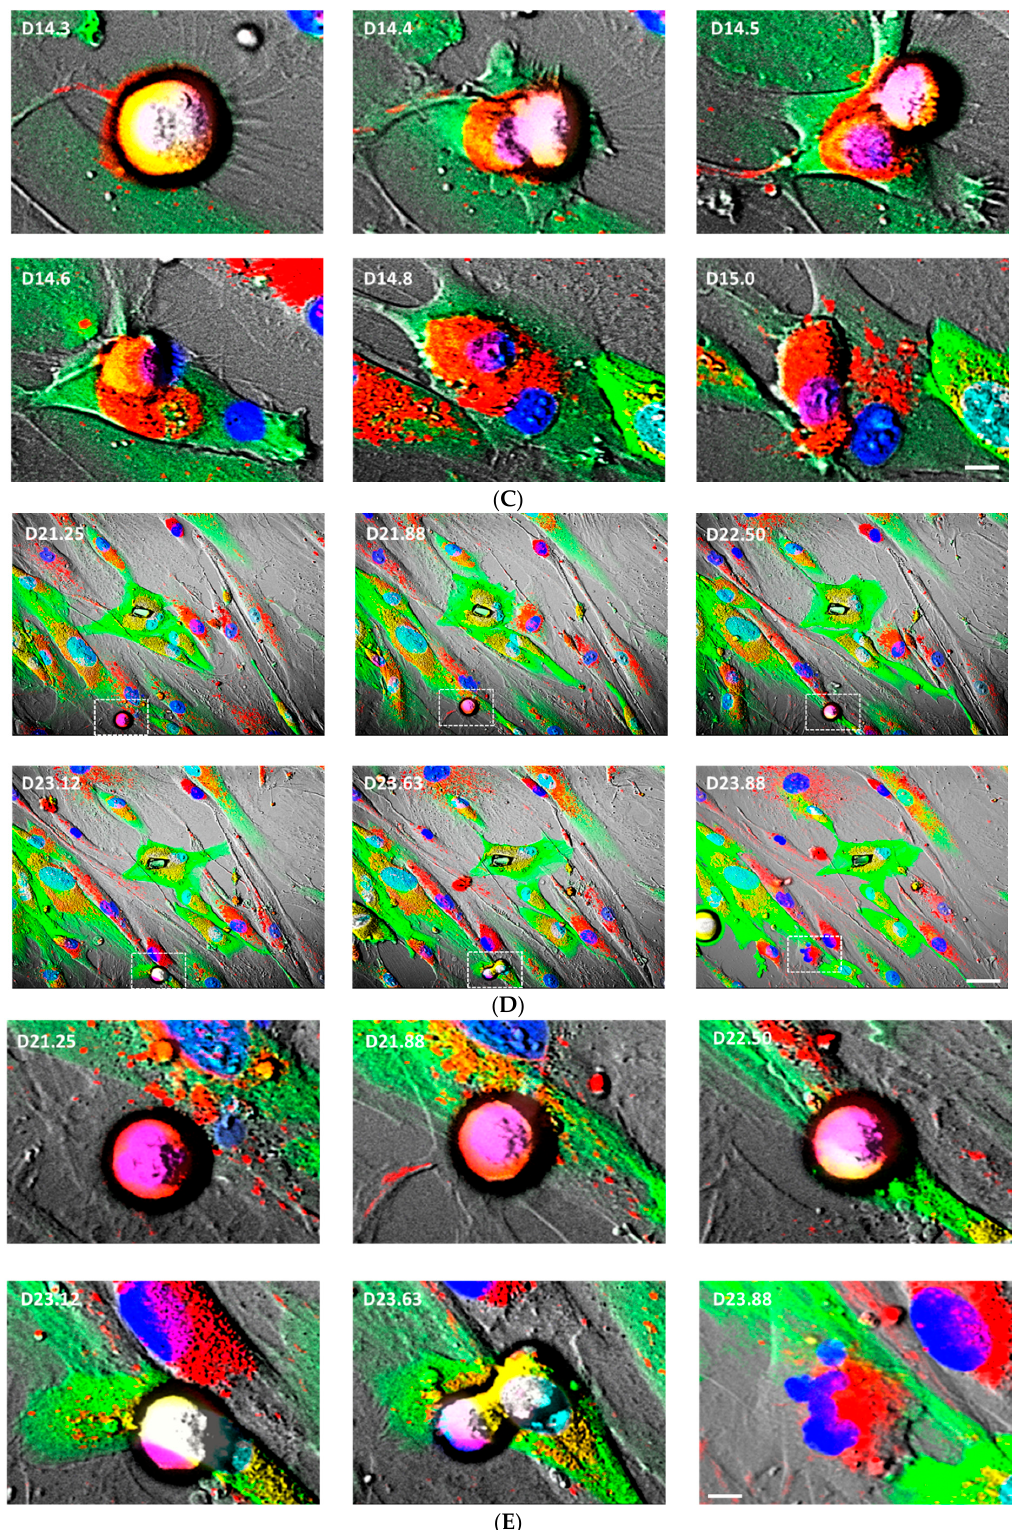
Figure 5. ( A ) Co-culture of eNOS-KD-hMSCs (green) and control hMSCs (red) on day 8 showing the transfer of mitochondria (red) and the restoration of adipogenesis in the eNOS-KD-hMSCs. Scale bar 10 µ m. ( B ) Adipogenesis and adipocyte replication in co-culture on days 14 to 15. ( C ) Close up of white dotted rectangular areas in ( B ), days 14–15. ( D ) Continued adipogenesis and adipocyte replication on days 23 to 24. Scale bar, 10 µ m. ( E ) Close up of white dotted rectangular areas in ( D ), days